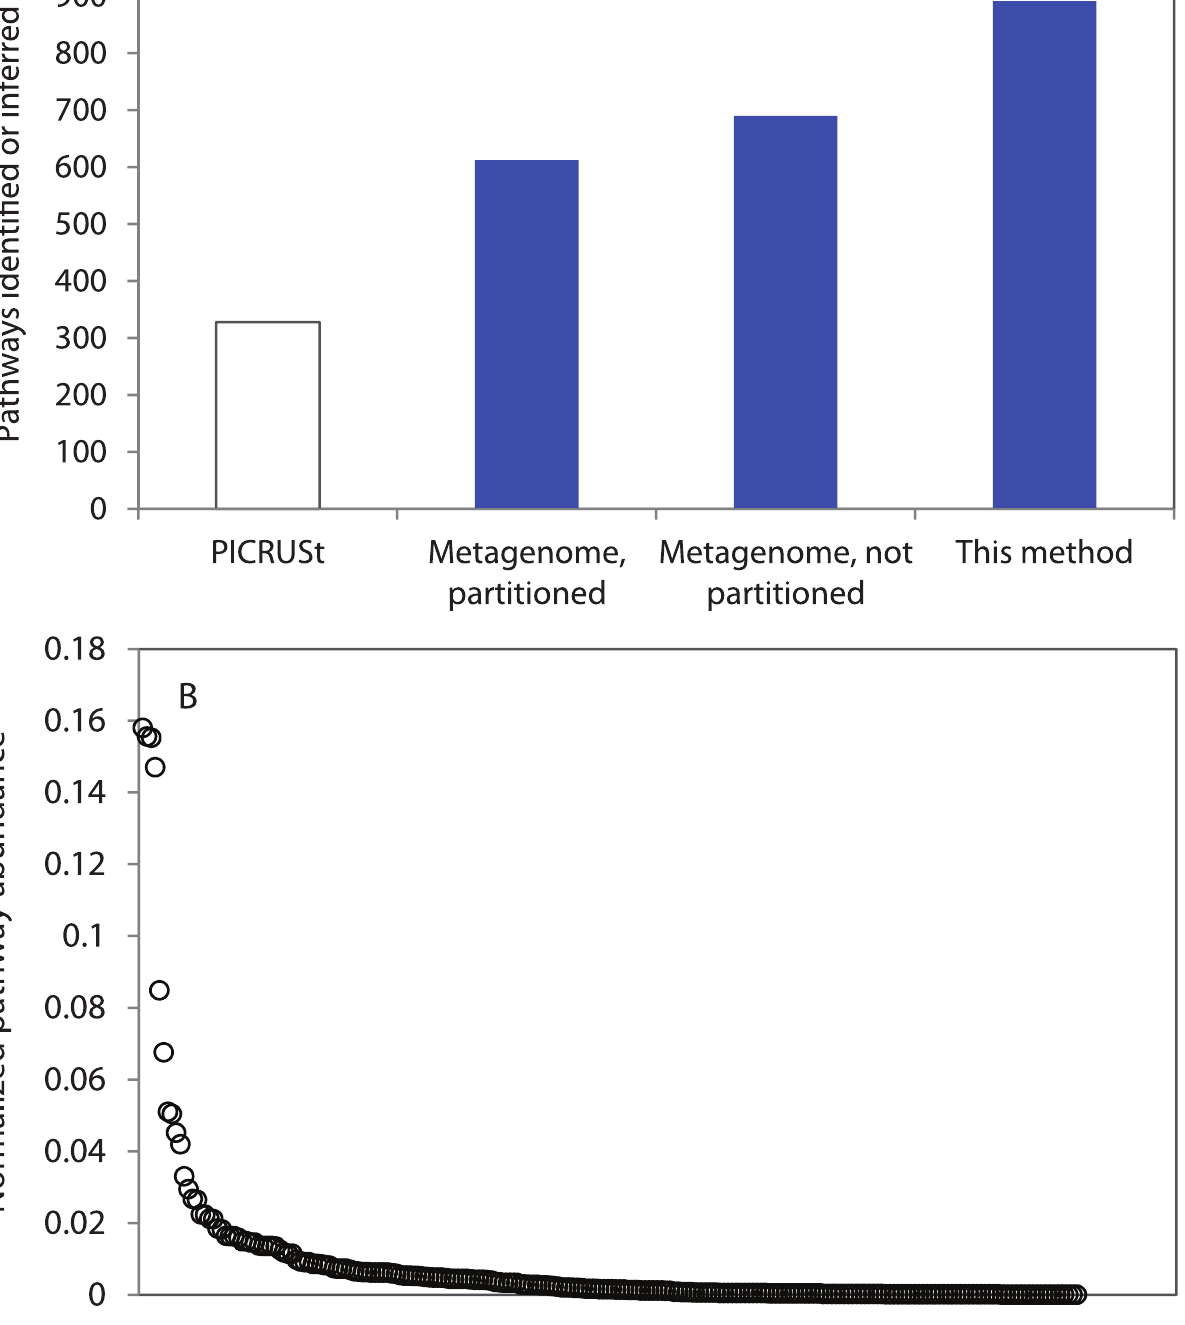
PLOS ONE | DOI:10.1371/journal.pone.0135868 August 18,